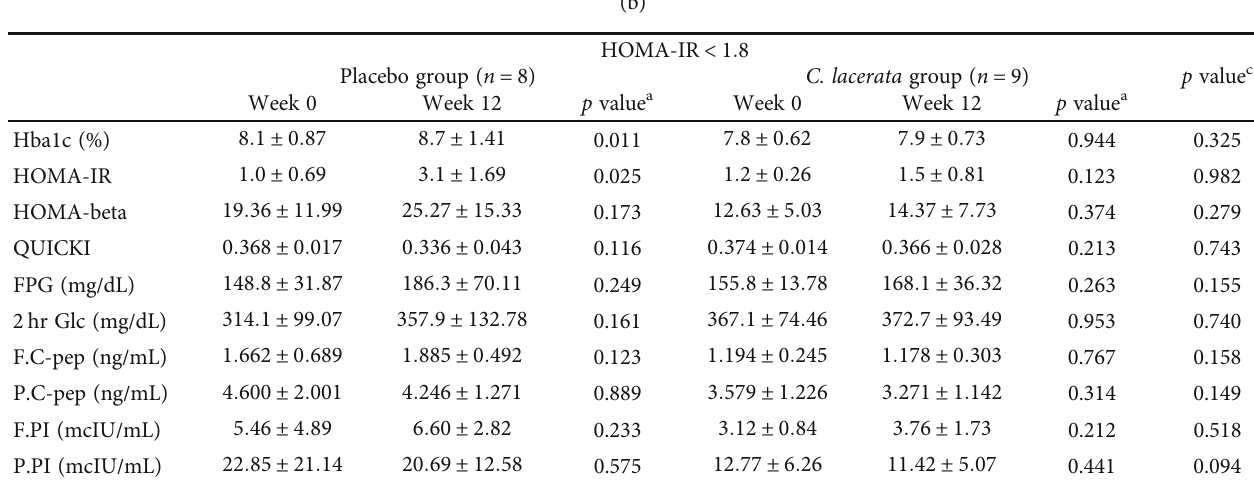
C. lacerata group ( n = 9